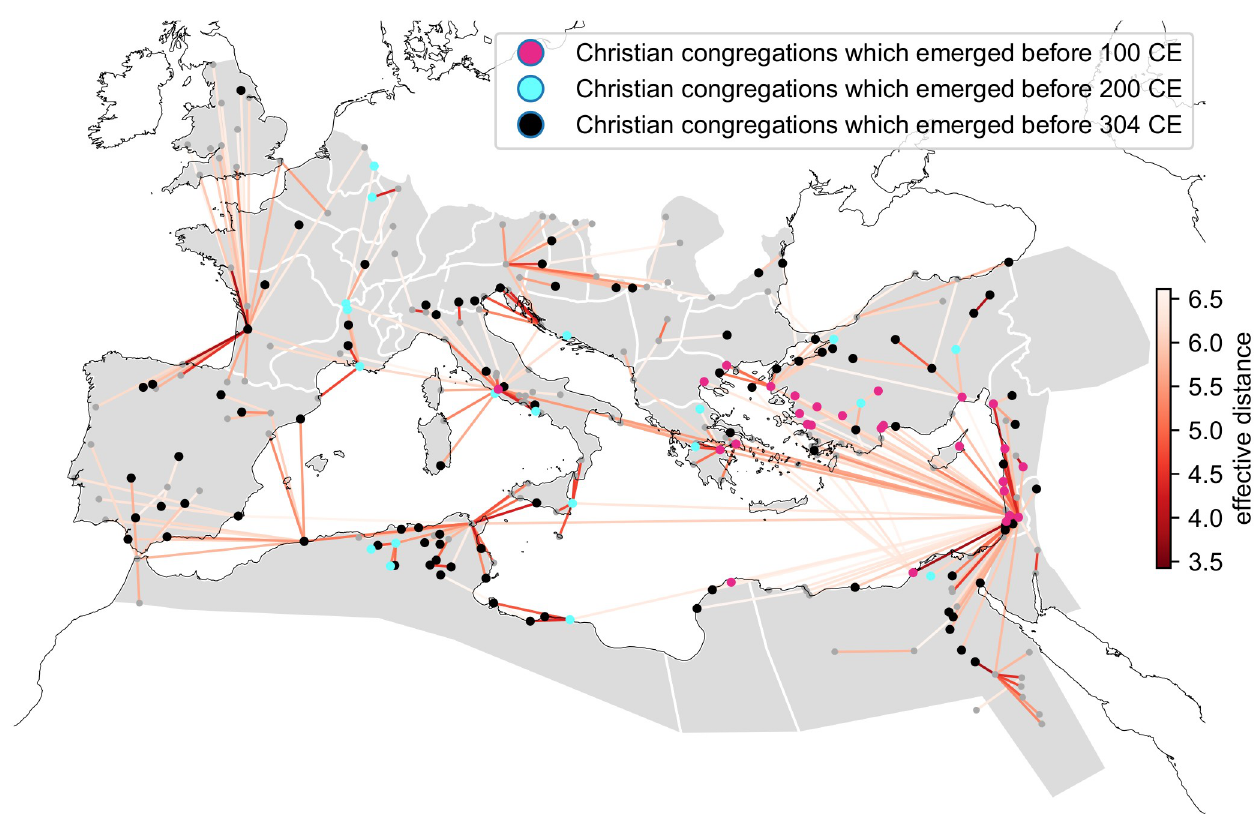
Fig 3. A geographical view of the shortest effective distance tree from